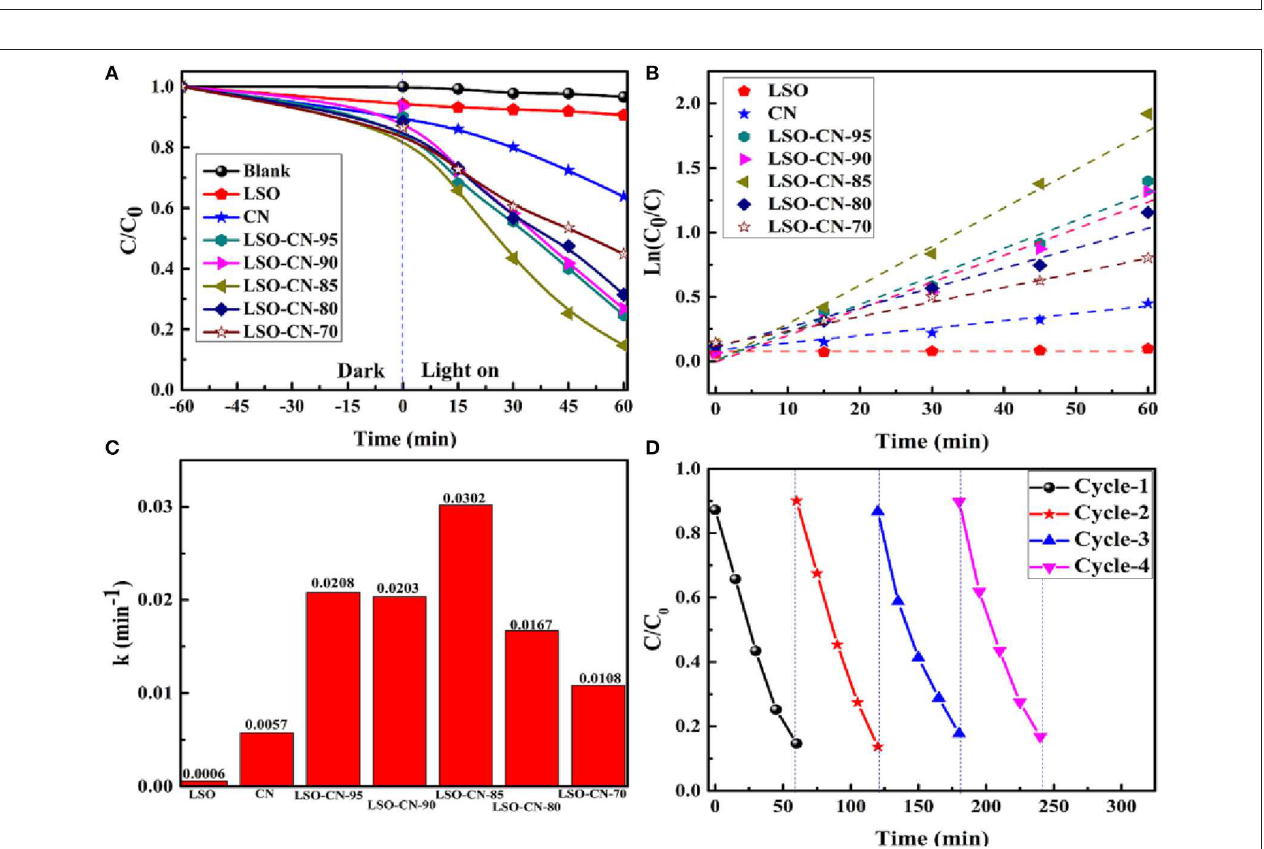
constants of Li 2 SnO 3 and g-C 3 N 4 were 0.0006 and 0.0057 where C 0 and C are the RhB concentration in solution at min − 1 , respectively. For the Li 2 SnO 3 /g-C 3 N 4 heterojunctions, time 0 and t , respectively. The quantity k is the fitted kinetic the corresponding kinetic rate constants of LSO-CN-70, LSO- rate constant. It can be seen that the plots of the irradiation CN-80, LSO-CN-85, LSO-CN-90, and LSO-CN-95 were fitted as are nearly straight lines, which reveals time t against ln C 0 C 0.0208, 0.0203, 0.0302, 0.0167, and 0.0108 min − 1 , respectively. that all the photocatalysts followed pseudo-first order kinetics The kinetic rate constant of the LSO-CN-85 was the in the photodegradation of the RhB solution. The kinetic rate